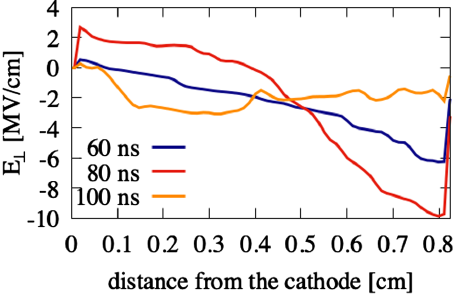
FIG. 5. E ⊥ as a function of position in the AK gap at 60, 80, and 100 ns. E ⊥ is extracted at r ¼ 10 cm in the simulation geometry in Fig. 2(a).